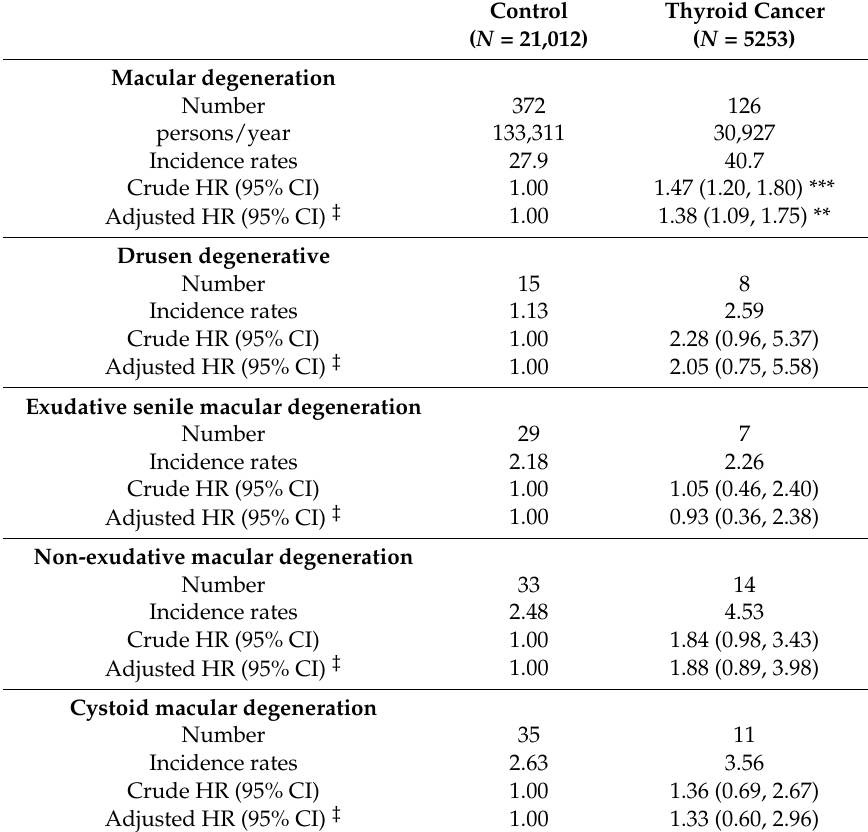
Table 2. Crude and adjusted hazard for macular degeneration in the thyroid cancer and control groups.